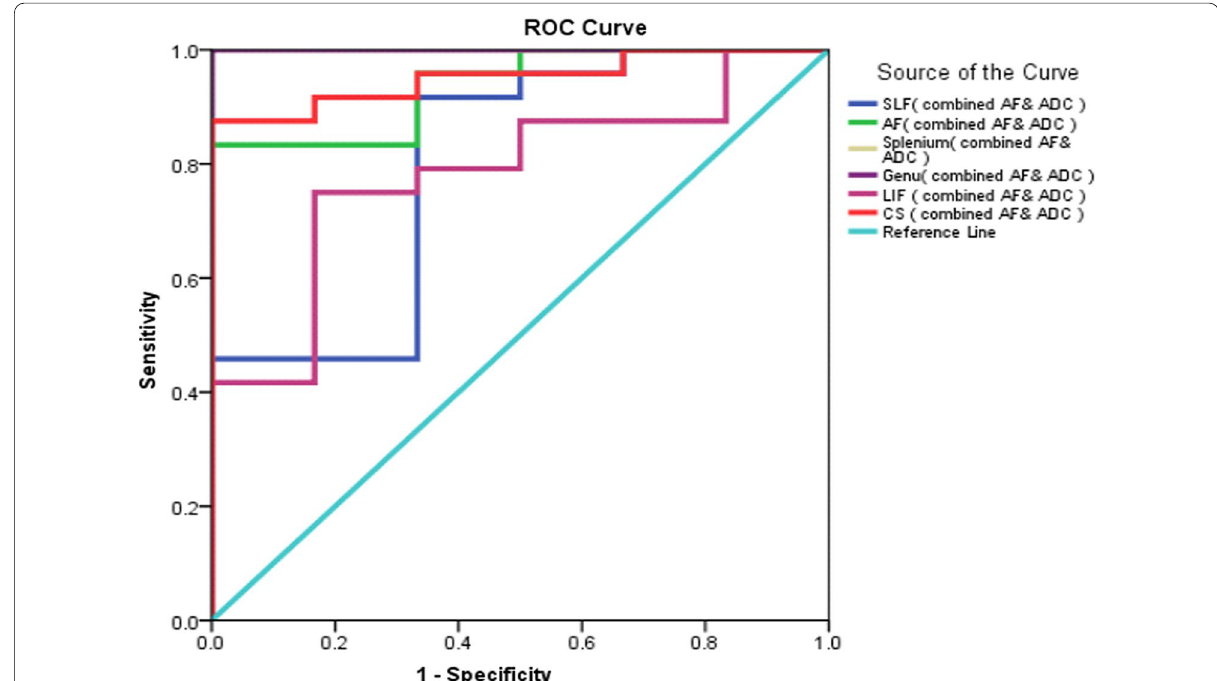
Fig. 4 ROC curve demonstrating specificity and sensitivity of combined FA and MD in genue, splenium and CS tract on both sides